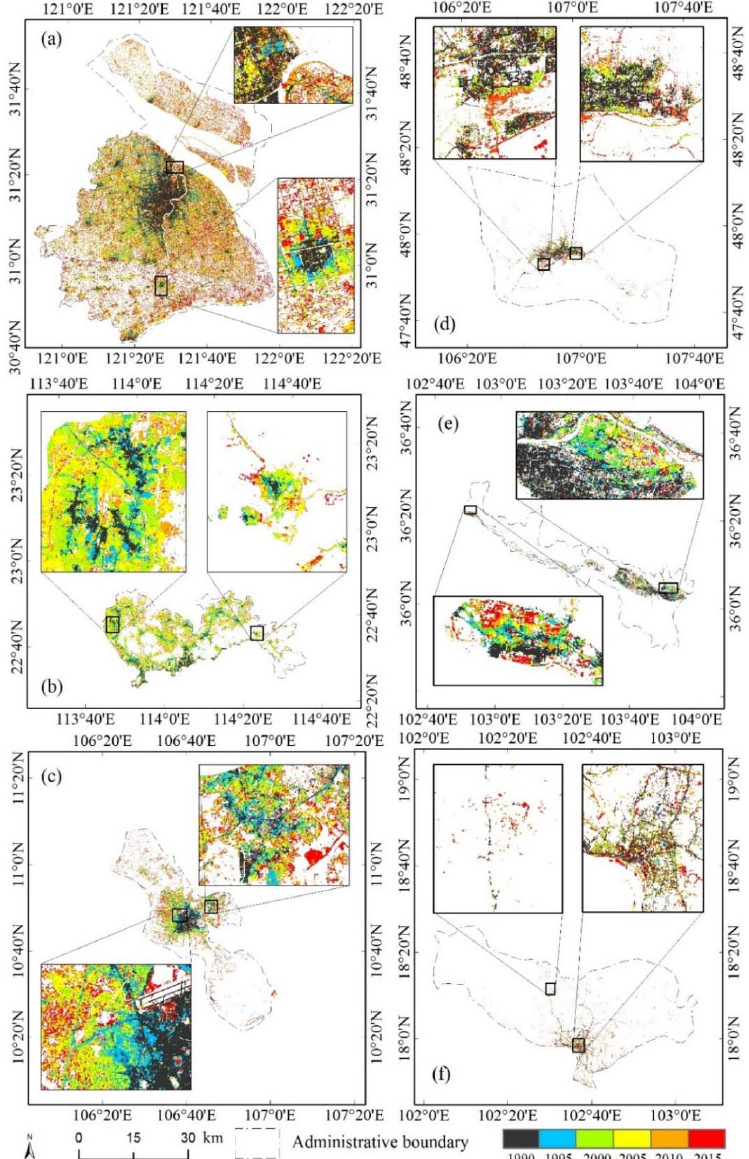
Figure 7. Spatial distribution of urban ISA expansion from 1990 to 2015 at five-year intervals for six Asian metropoles; ( a ) Shanghai, ( b ) Shenzhen, ( c ) Ho Chi Minh City, ( d ) Ulaanbaatar, ( e ) Lanzhou, and ( f ) Vientiane.